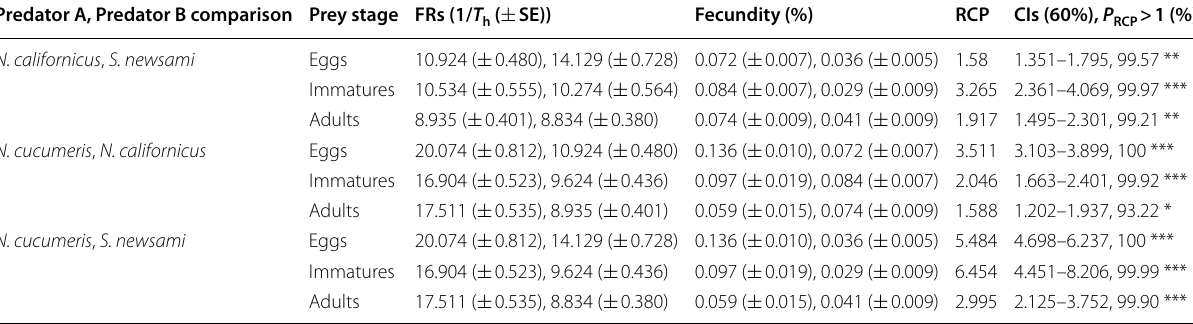
RCP score is > 1 (* > 95%, ** > 99%, *** > 99.9%)